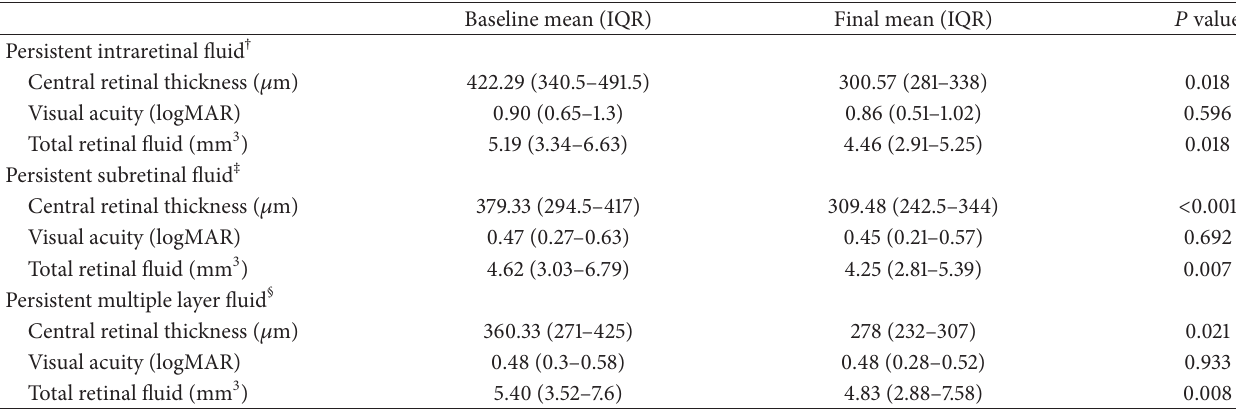
Table 4: Subgroup anatomical and visual measurements following aflibercept.